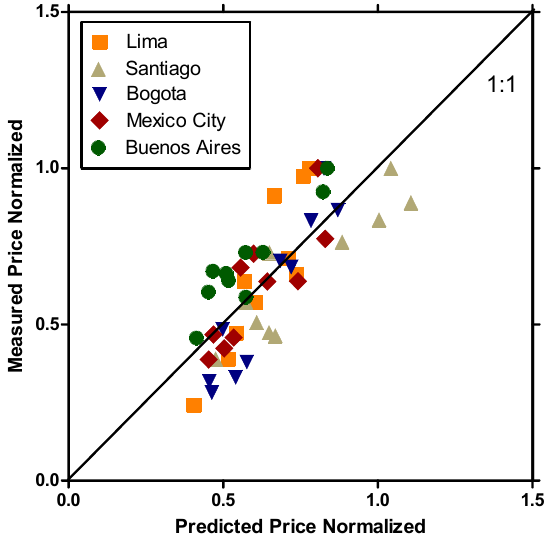
Figure 2. Relationship between measured prices and predicted price at district level. Predicted values obtained via multiple regression: Predicted Price Normalized (NOR) = 0.35 + 0.71*av/at NOR − 0.053*Population Density NOR + 0.34*Business Density NOR − 0.061*Crime Density NOR. See Table 2 for details. Diagonal line indicates the 1:1 relationship. The normalized data used in this analysis adhere closely to the 1:1 line (which indicates close correspondence between the measured and predicted values and shows the robustness of the multiple regression model.